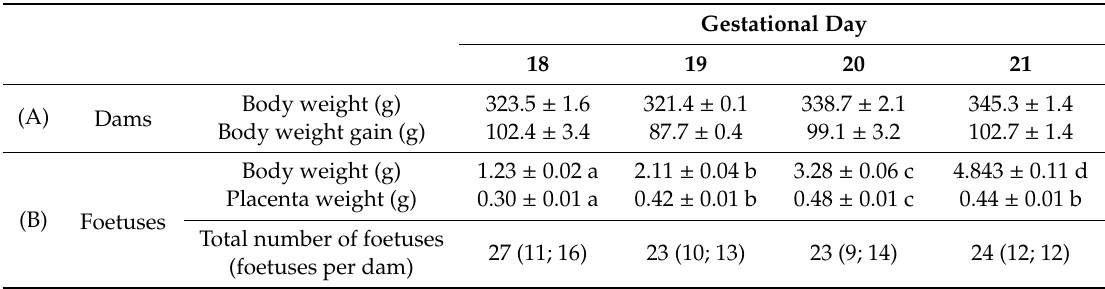
Table 1. Weight-related parameters. ( A ) Dams’ body weight at sacrifice (gestational day (GD) 18 to 21) and body weight gain (calculated as the increase of body weight from conception day (day 0) to final weight at day of sacrifice). ( B ) Body weight, placenta weight, and number of foetuses at sacrifice (GD 18 to 21).